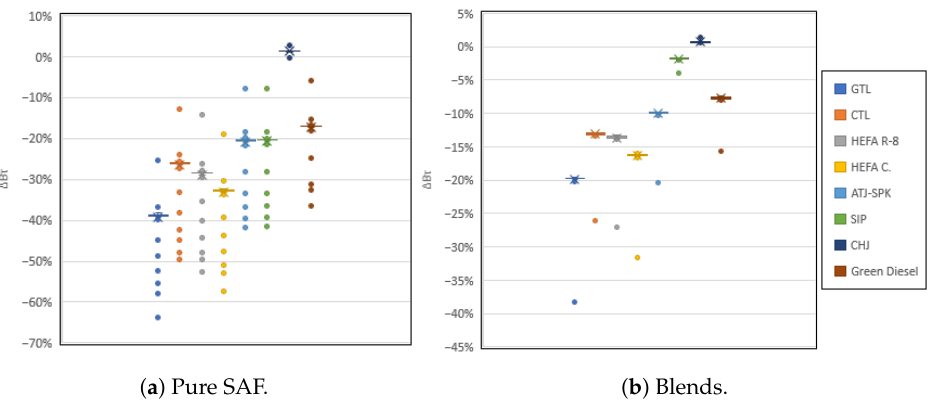
Figure 18. RDs in the product of contrail width by contrail optical depth for ambient relative humidities at formation in the range of 43% to